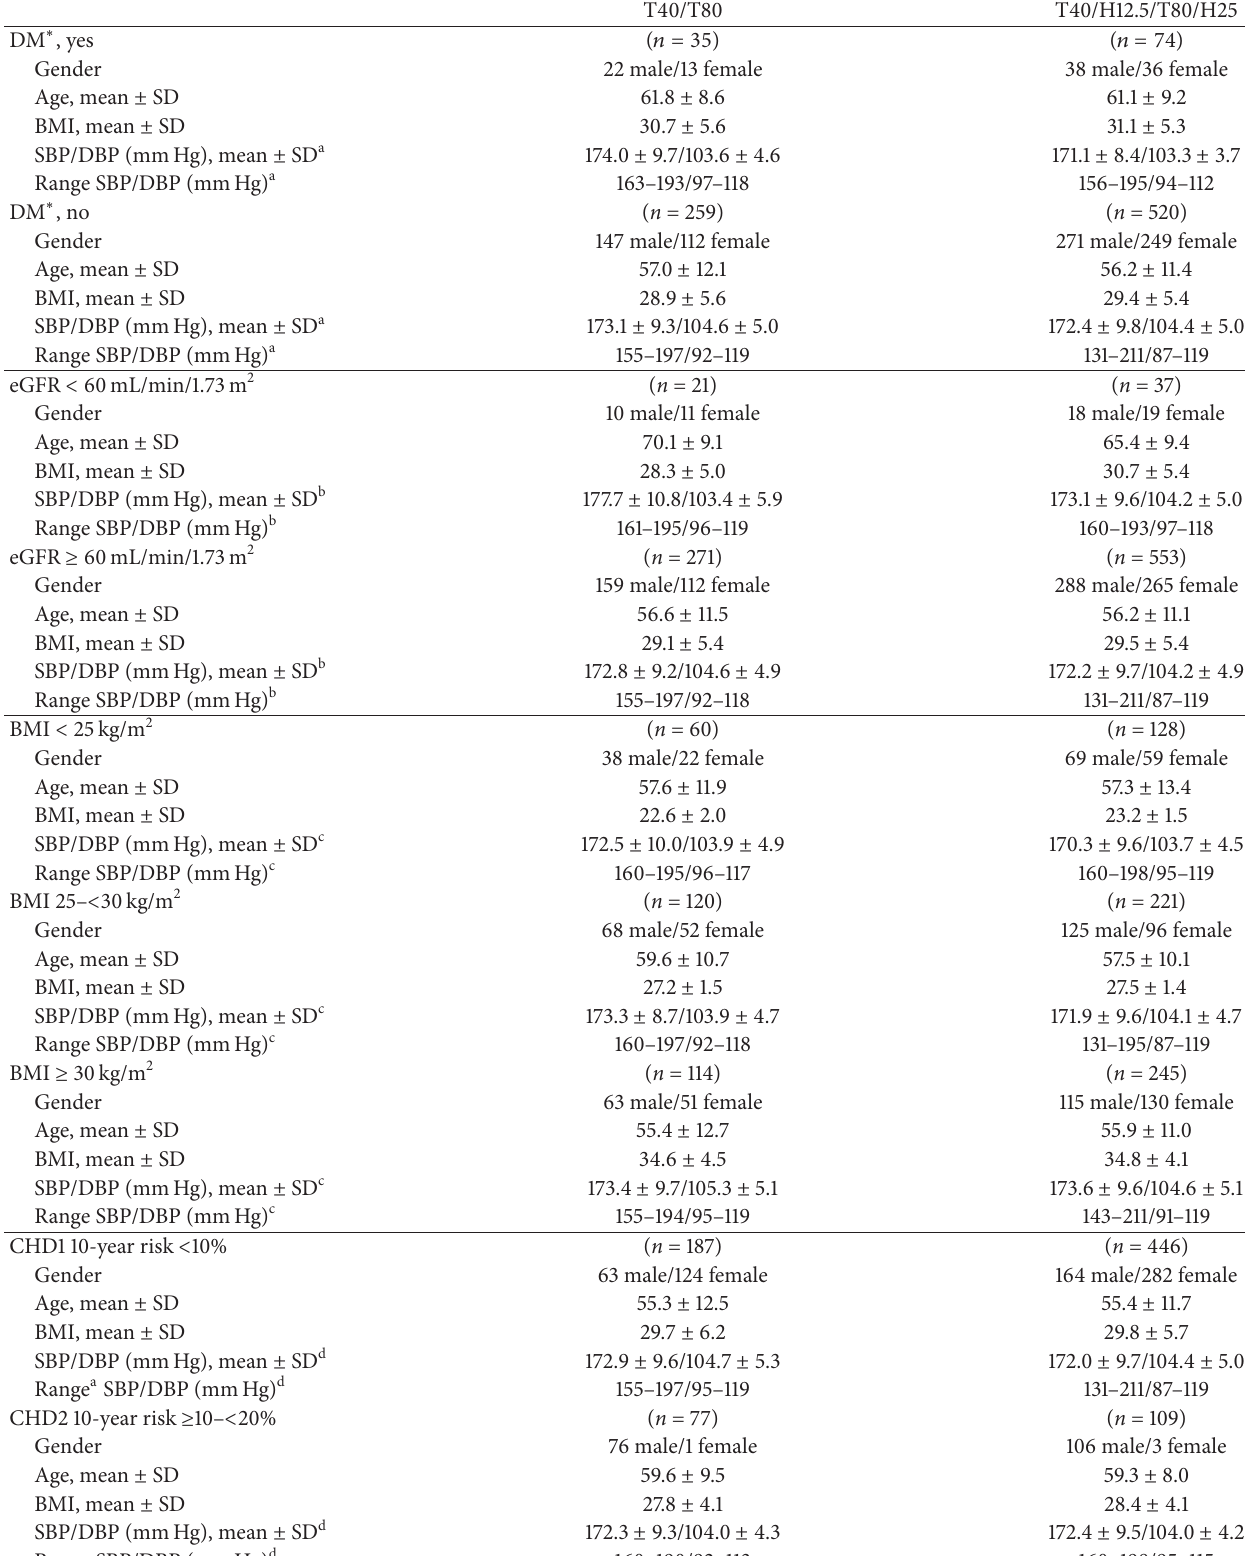
Table 1: Baseline characteristics in the different patient subpopulations, based on treated